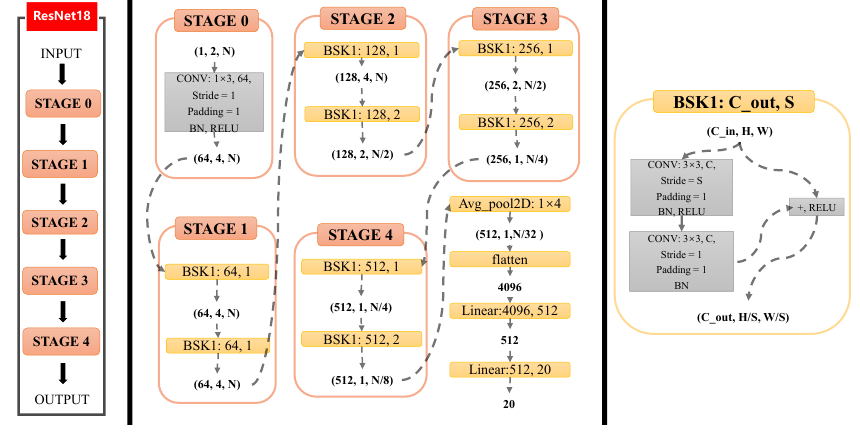
Figure 4. Deep learning network structure based on ResNet18 of SEI. N represents the data